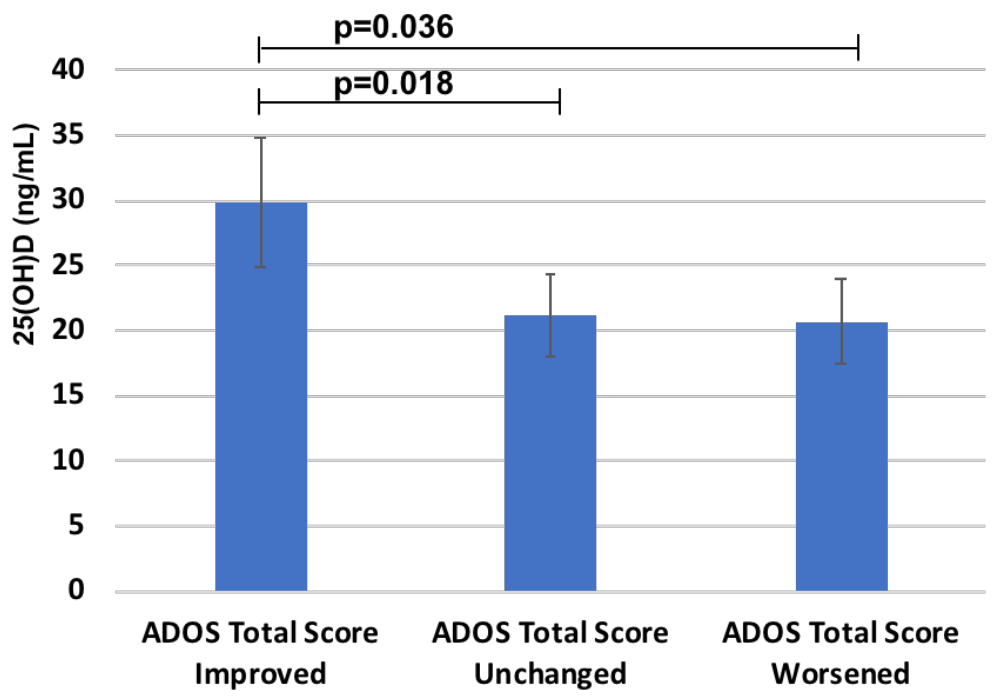
Figure 3. 25(OH)D levels in the groups with different response to probiotics treatment on ADOS Total score.